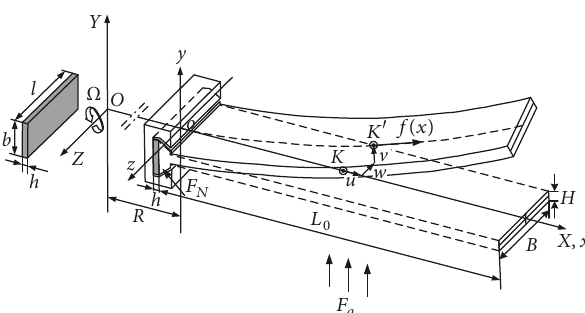
Figure 2: Schematic diagram of cantilever beam with viscoelastic damping